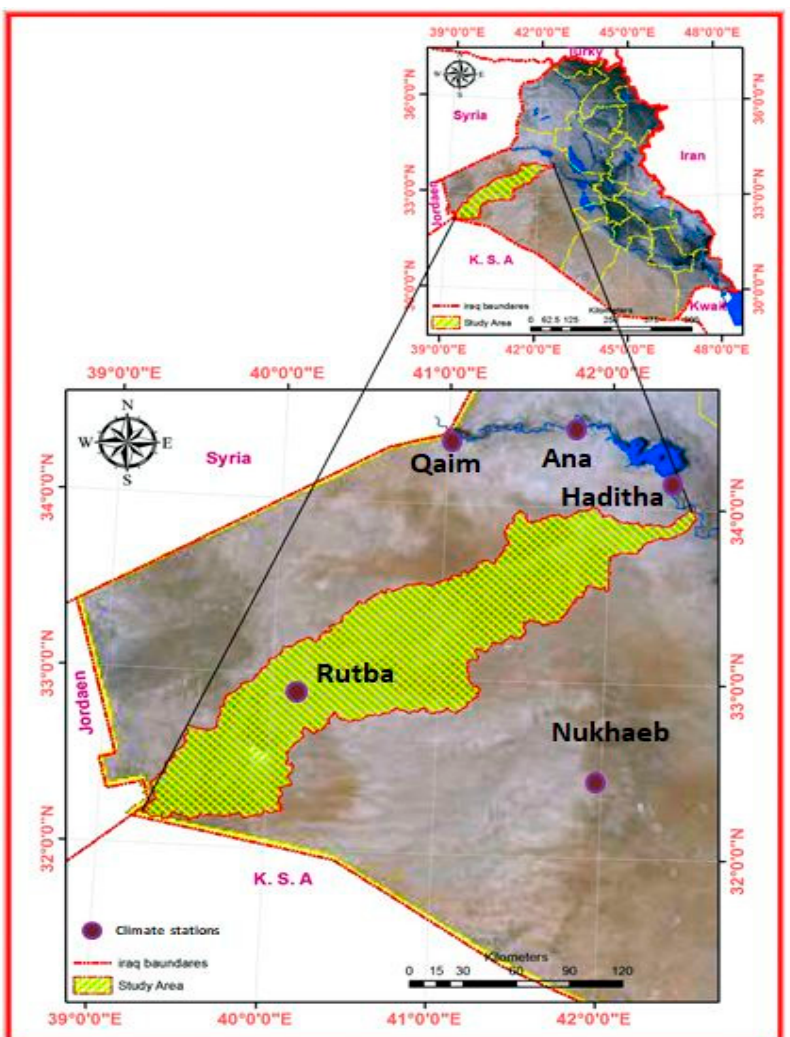
Figure 1. Area of study: the Wadi Horan in the western part of Iraq and the rain stations available for the region.